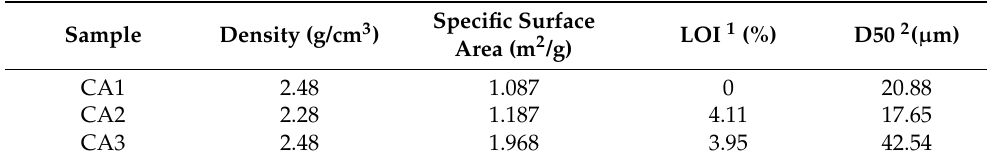
Table 2. Physical properties of three coal ash samples.